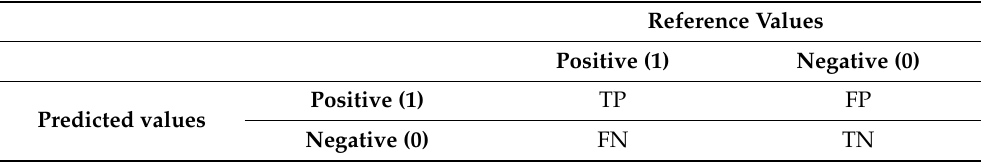
Table 1. Confusion matrix schematic design. FP is the false positive, TP is the true positive, FN is the false negative, and TN is the true